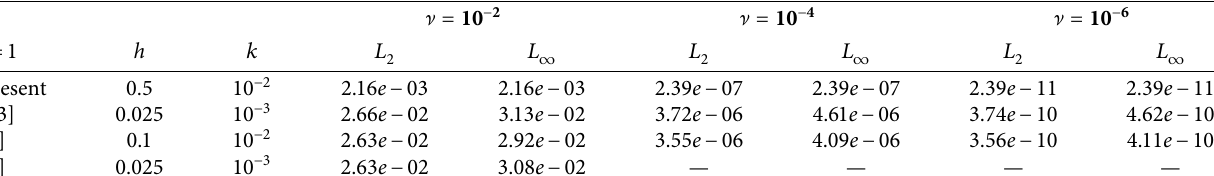
Table 4: Solution of the equation at time t � 1 for the second test problem.